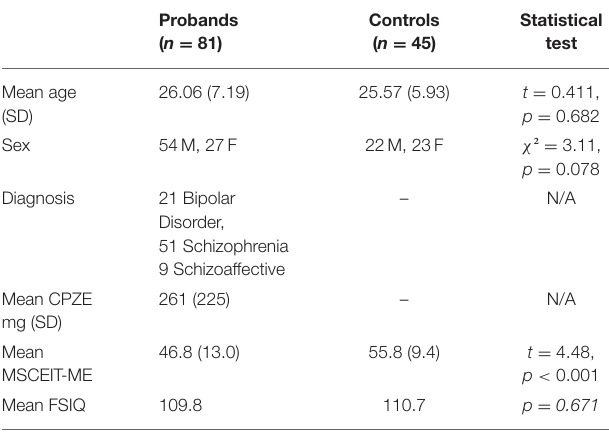
TABLE 1 | Demographic and clinical information by